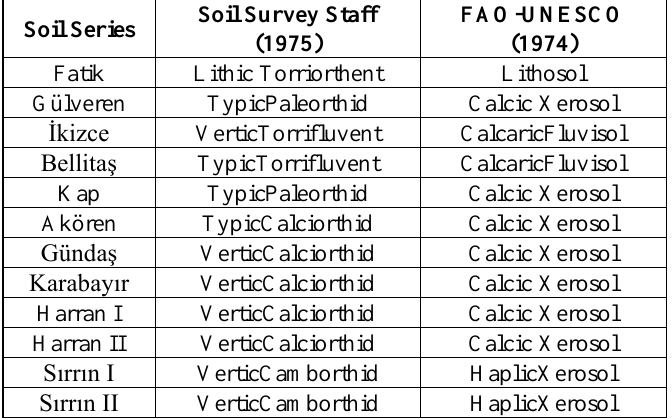
Table 1: Soil series classification according to Soil Survey Staff (1975) and FAO-UNESCO